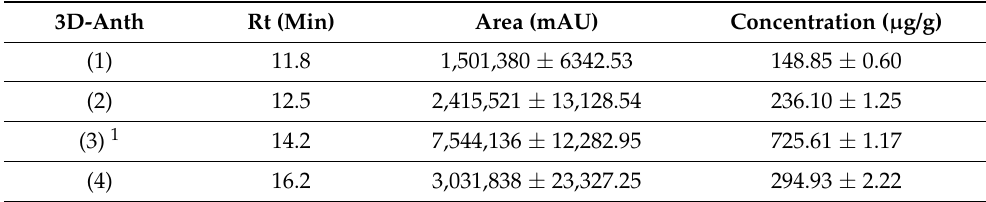
Table 9. 3-Deoxyanthocyanidins (3D-anth) content in A. chica leaf extracts ( µ g/g dried plant material) expressed as